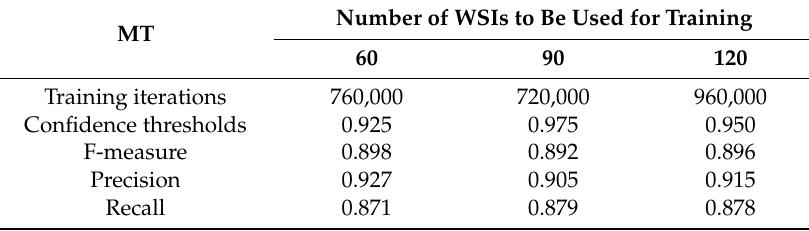
Table A3. Details of detection performance corresponding to the number of WSIs to be used for training the network (MT).